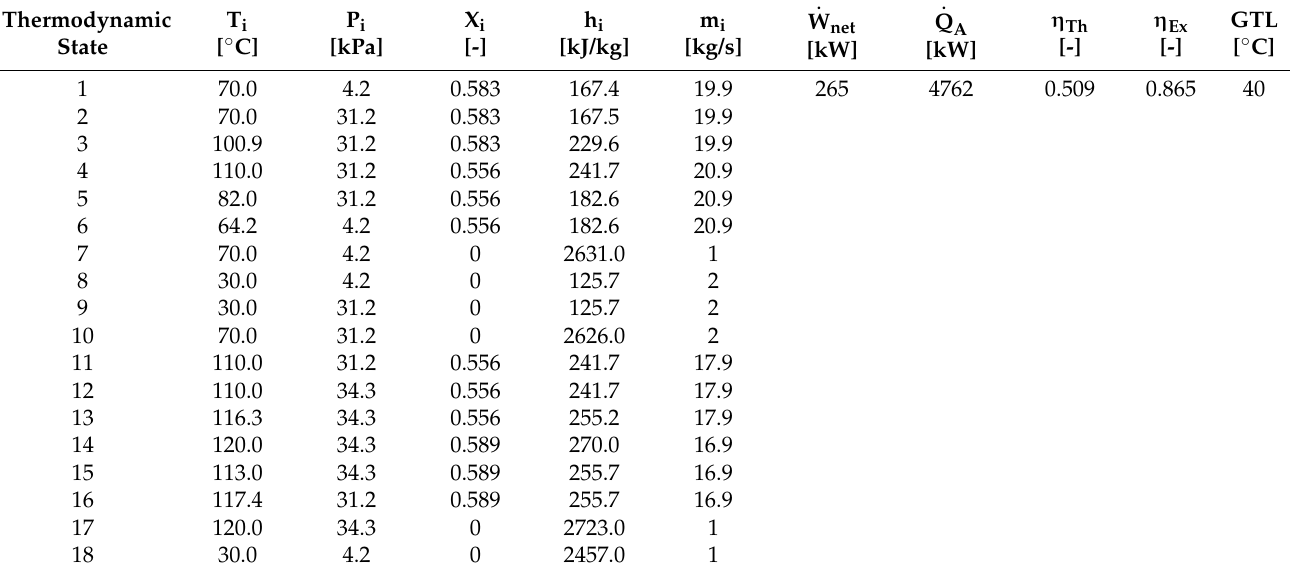
Table 2. Thermodynamic simulation of the MAHP. Case study: T C = 30 ◦ C, T GL = 70 ◦ C, T GH = 120 ◦ C, RP =